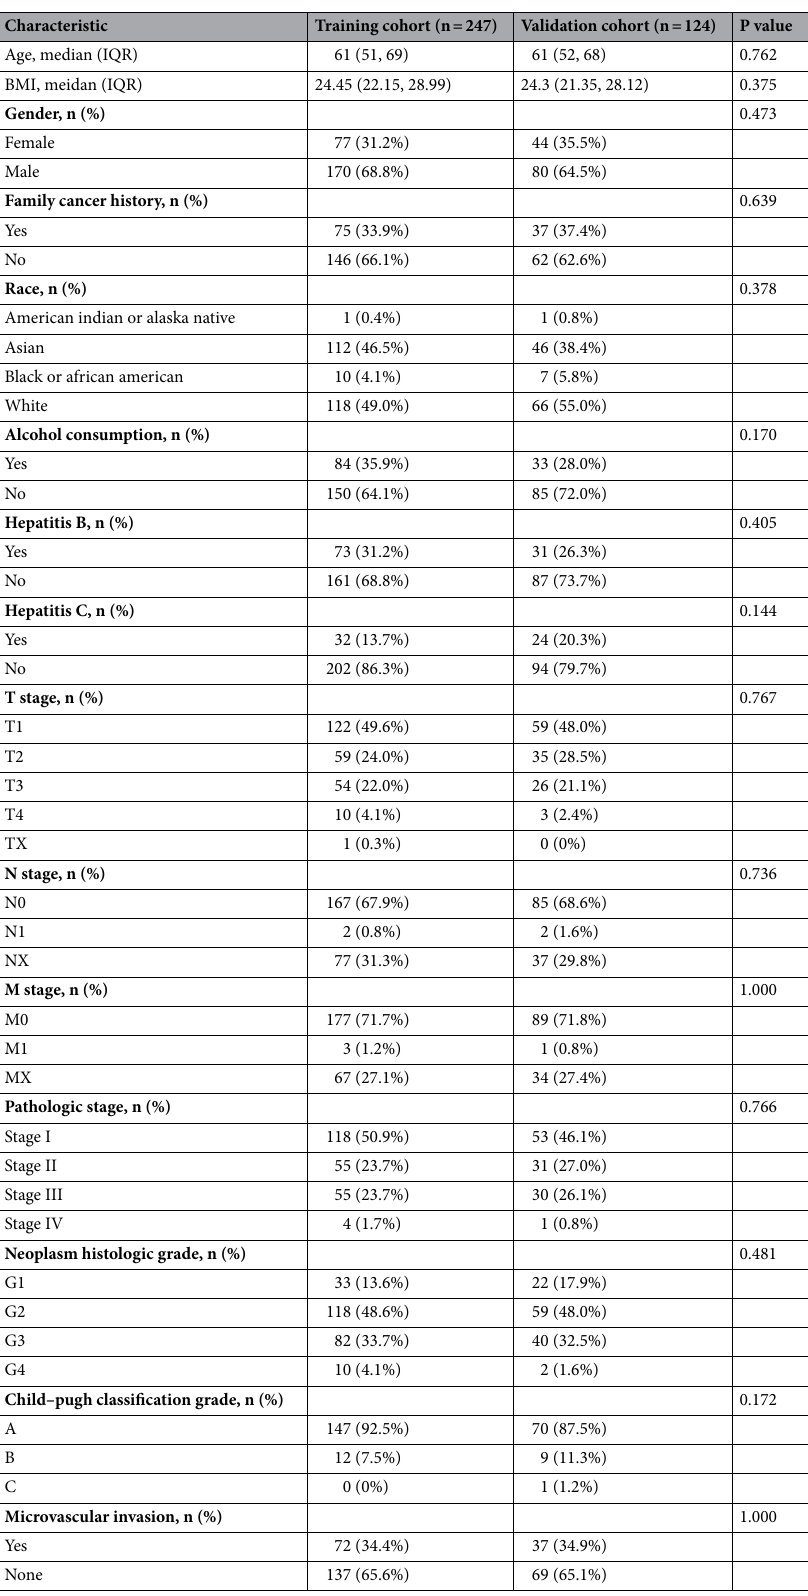
Table 1. The characteristics of HCC patients in training cohort and validation